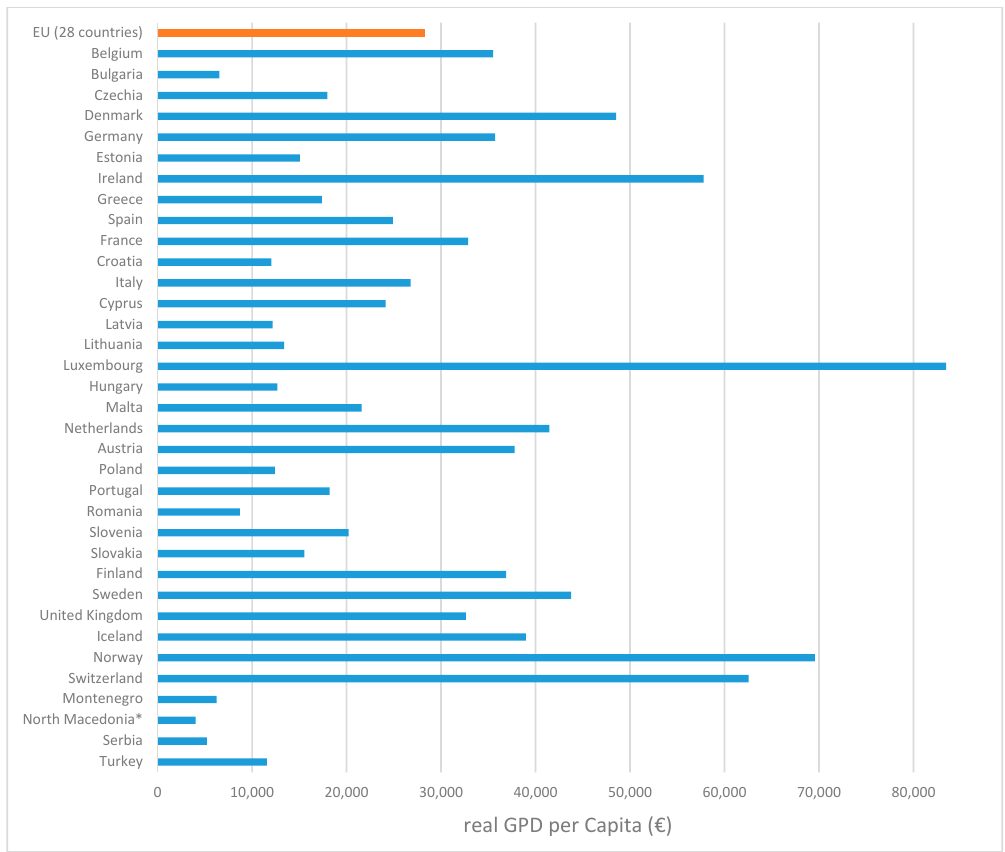
Figure 2. Economic development (measured as the gross domestic product (GDP) per capita, in EUR) of EU-28 member states in 2018 [14] (* 2018 value was not available for North Macedonia; therefore, the 2017 value is shown).